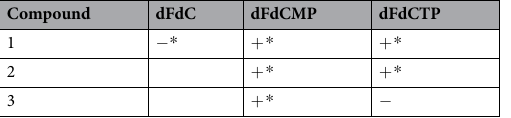
Table 1. Host-guest interactions observed in 2D ROESY NMR spectra. + Inclusion complex; − no complex; * possible external